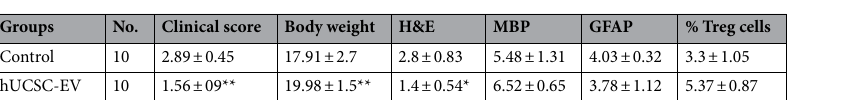
of IFN-γ, TNF-α, and IL-17a significantly decreased by splenocytes from hUCSC-EVs-treated mice compared to EAE control mice (p < 0.001, p < 0.01, and p < 0.001, respectively). Our results also demonstrated that the amount of anti-inflammatory cytokines (IL-10 and IL-4) production was significantly increased by splenocytes from hUCSC-EVs-treated mice compared to EAE control mice (p < 0.001 and p < 0.05, respectively) (Fig. 5). hUCSC‑EVs treatment reduce leukocyte infiltration in spinal cord of EAE mice. Based on the immunomodulatory effect of hUCSC-EVs, we evaluated the leukocyte infiltration in spinal cord of experimental